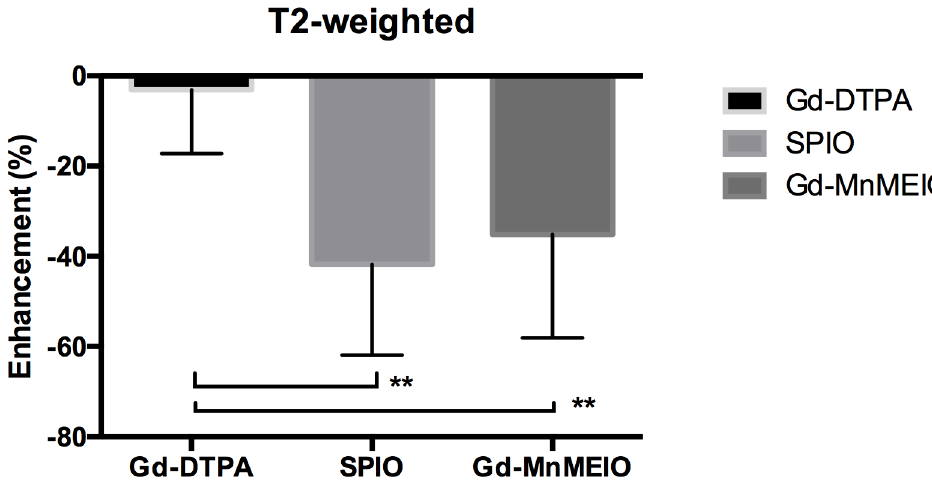
Fig 7. T2 enhancement effect at 30 min after administration of Gd-DTPA (n = 9), SPIO (n = 15), and Gd- MnMEIO (n = 6). The error bars indicate standard deviation. Significant difference is indicated by ** p < 0.01.